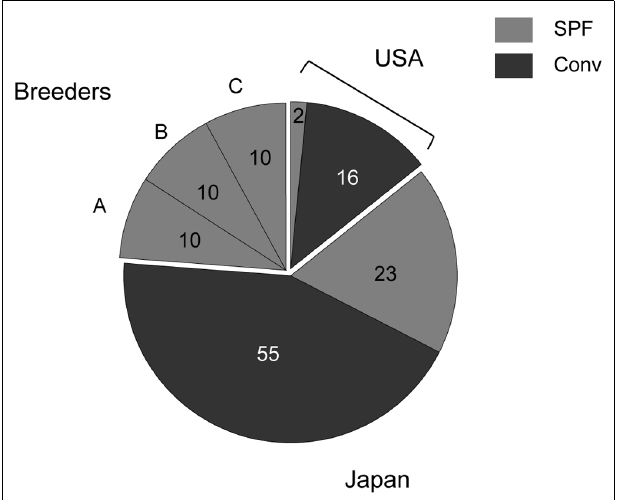
FIGURE 1 | Numbers of tested mice. Two SPF and 16 conventional mice derived from US animal facilities, 23 SPF and 55 conventional mice derived from domestic facilities, and 10 of each SPF female C57BL/6 mouse obtained from breeders A, B, and C were tested in this study.